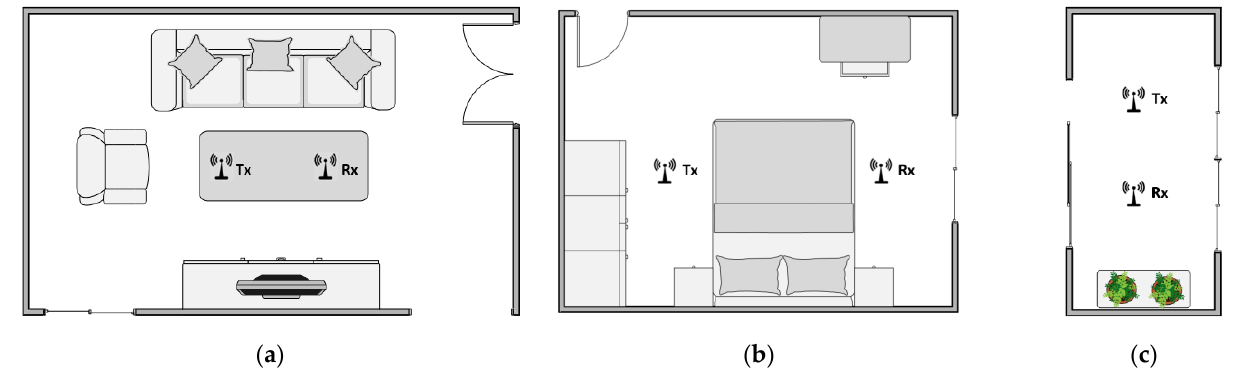
Figure 10. Plan of the experimental scenarios. ( a ) Living room. ( b ) Bedroom. ( c ) Balcony.